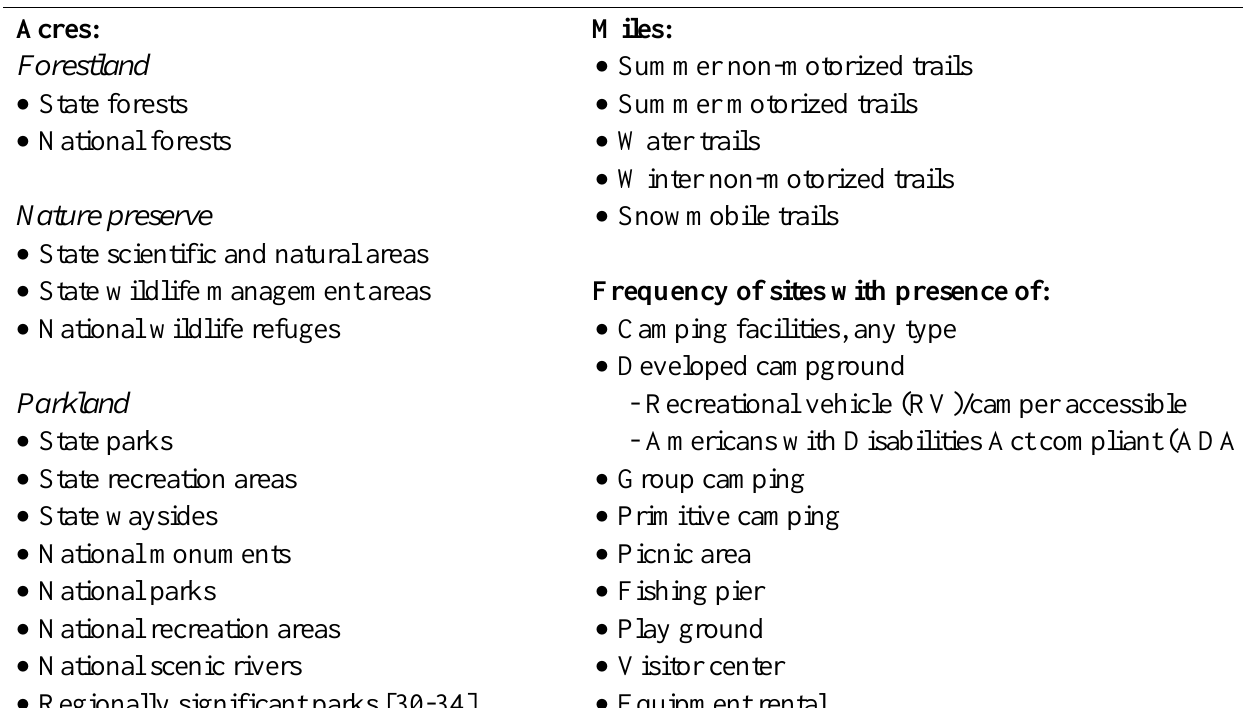
Table 1. Inventoried supply